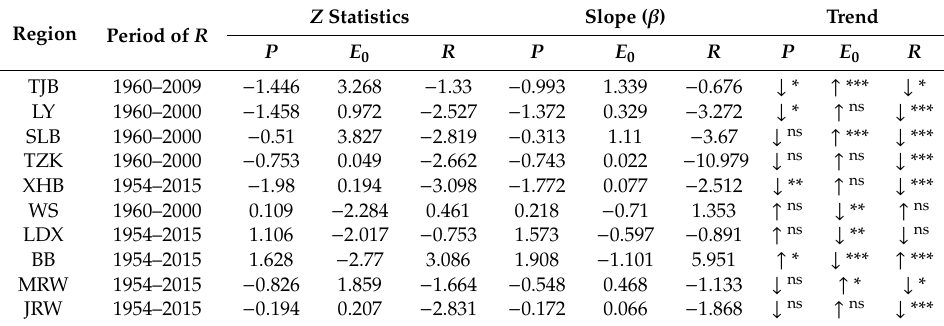
Table 1. Mann–Kendall test and Sen’s slope estimator analysis results for discharge.